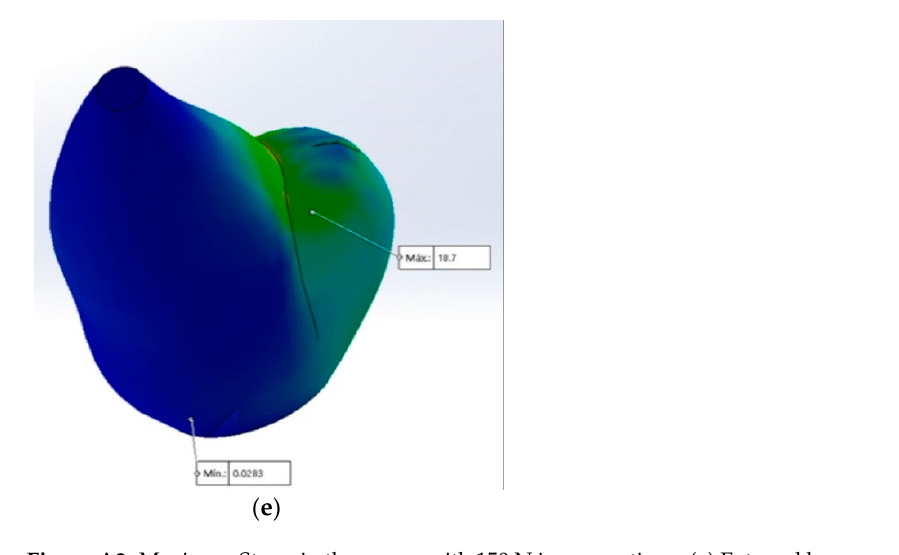
( e ) Figure A3. Maximun stress in the abutment with 150 N: ( a ) External hexagon; ( b ) internal hexagon; ( c ) morse taper; ( d ) conical connection; ( e ) conical triangular connection.